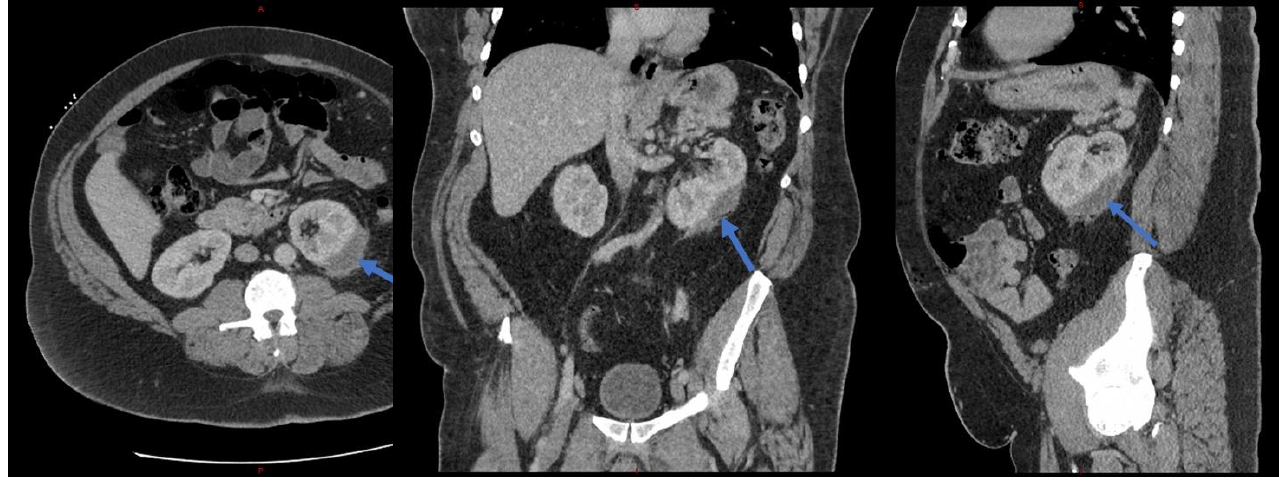
Fig. 1. CT abdomen with contrast showing left renal subcapsular fluid collection (indicated by the blue arrows) measuring approx. 7.1 x 5.4 x 2.3 cm, suggestive of a Page kidney.